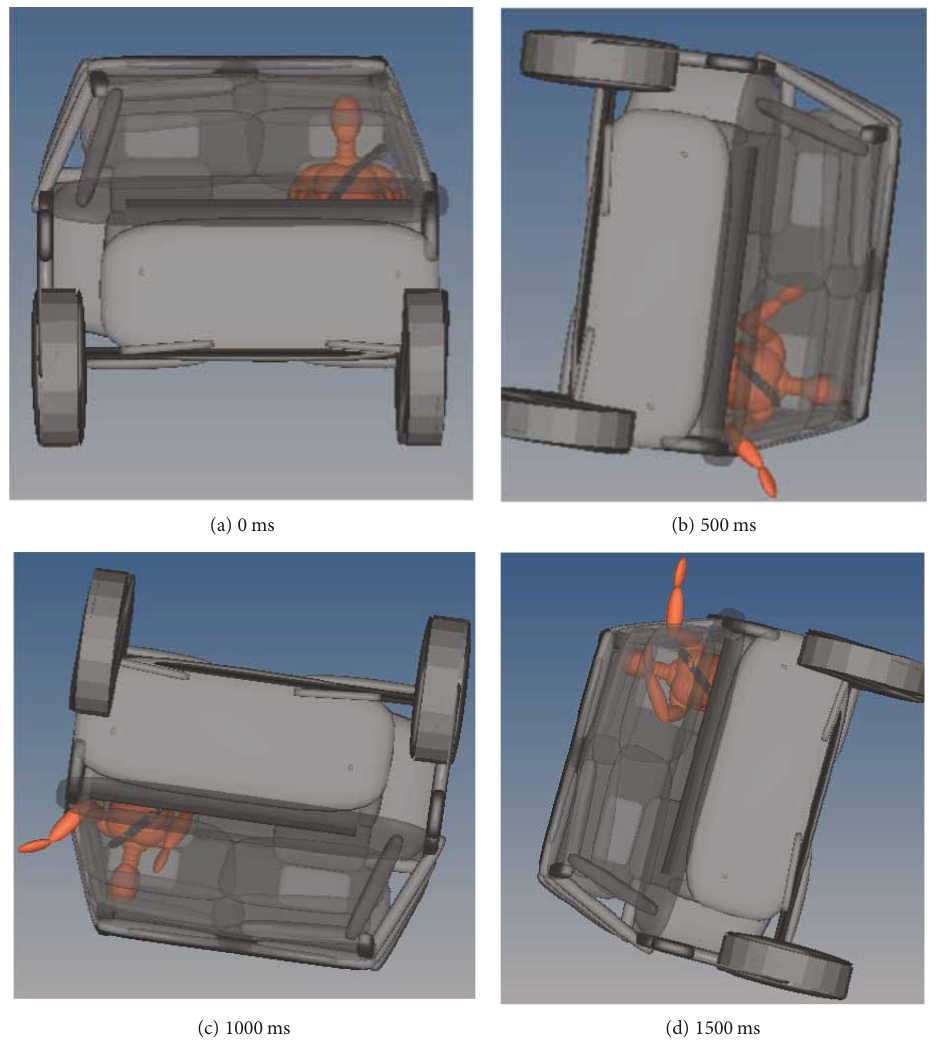
Figure 4: Occupant kinematics in rollover simulation.